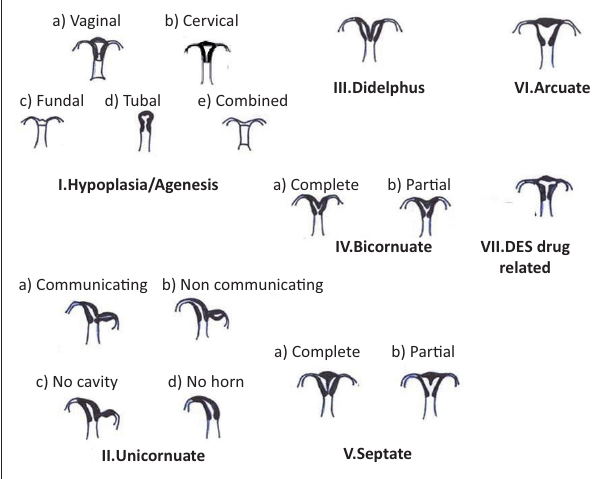
FIGURE 4: The American Society for Reproductive Medicine classification.